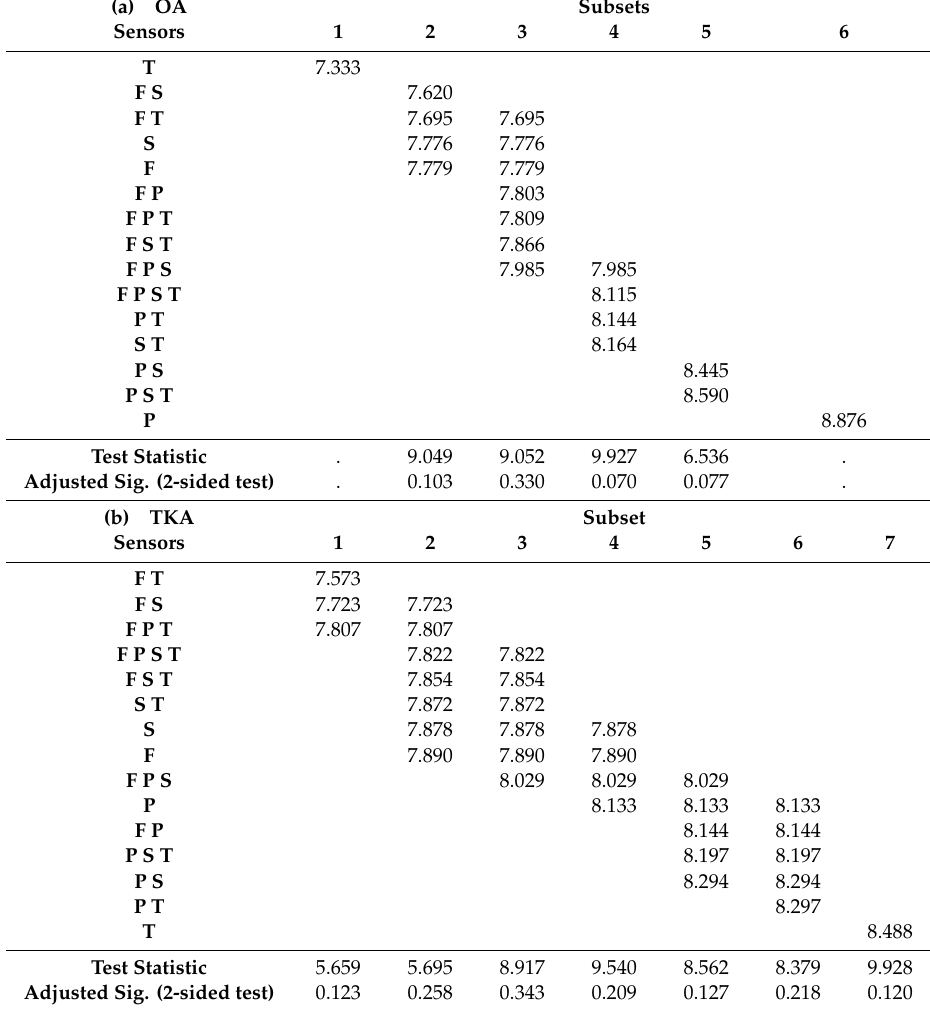
Table A2. Homogeneous subsets based on Freidman ranking and asymptotic significances (0.05)